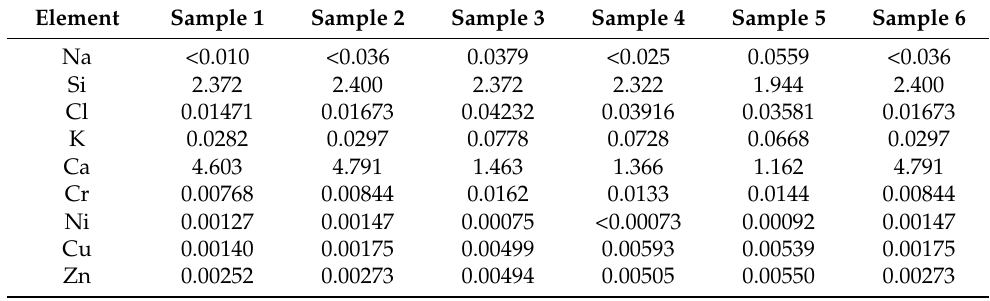
Table 3. Elements obtained in stormwater samples (concentration, %) (Paneriai, Vilnius Region).